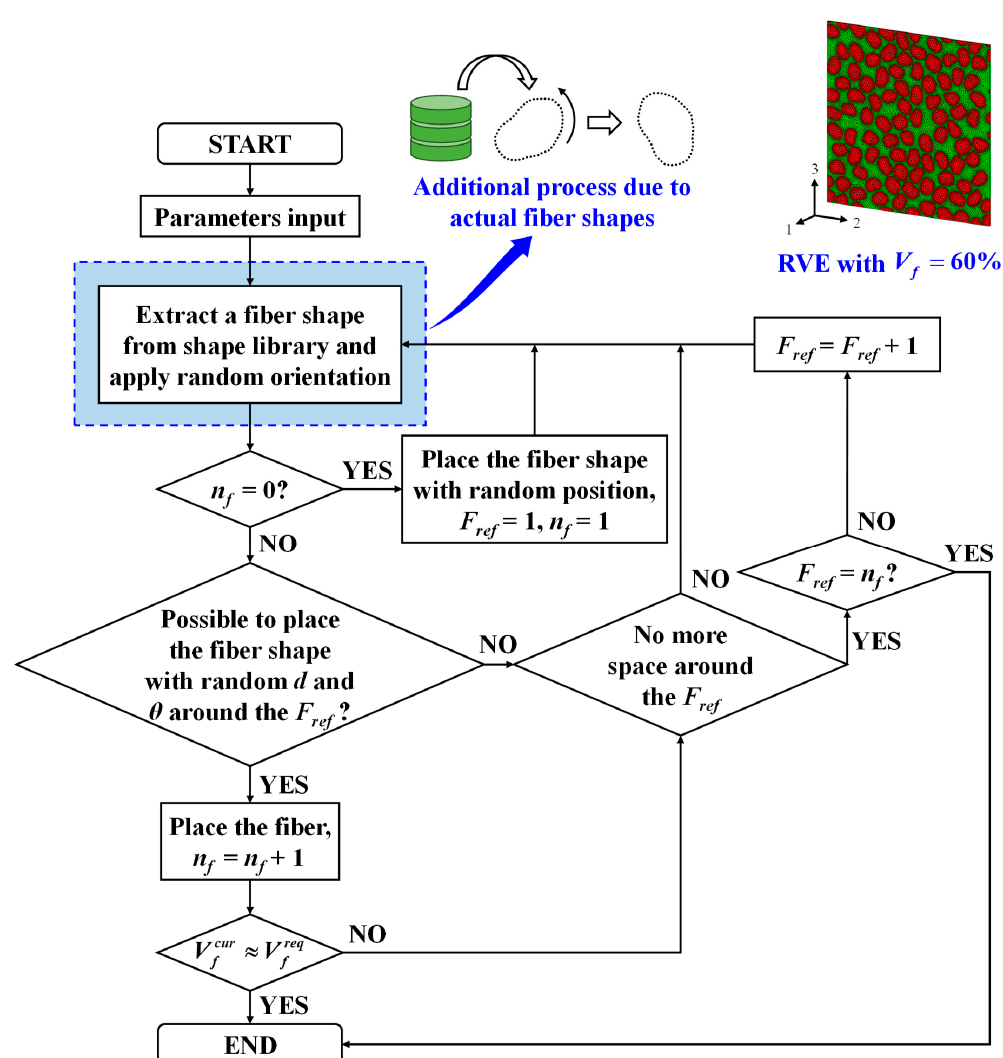
Figure 4. Flowchart of the RSE algorithm and its modification for the actual noncircular fibers. = Diverse fiber arrangements were made to have f V 60%, 55%, 45%, 35%, 25%, 15%, and 5% in × the square window of 10 10, and 100 samples were generated for each f V . To avoid clustering of fibers, which routinely occurs with the RSE algorithm, variables min l and max l for the minimum distance between the fibers were determined through extensive trial and error as summarized in Table 1. Table 1. Minimum distance between fibers corresponding to